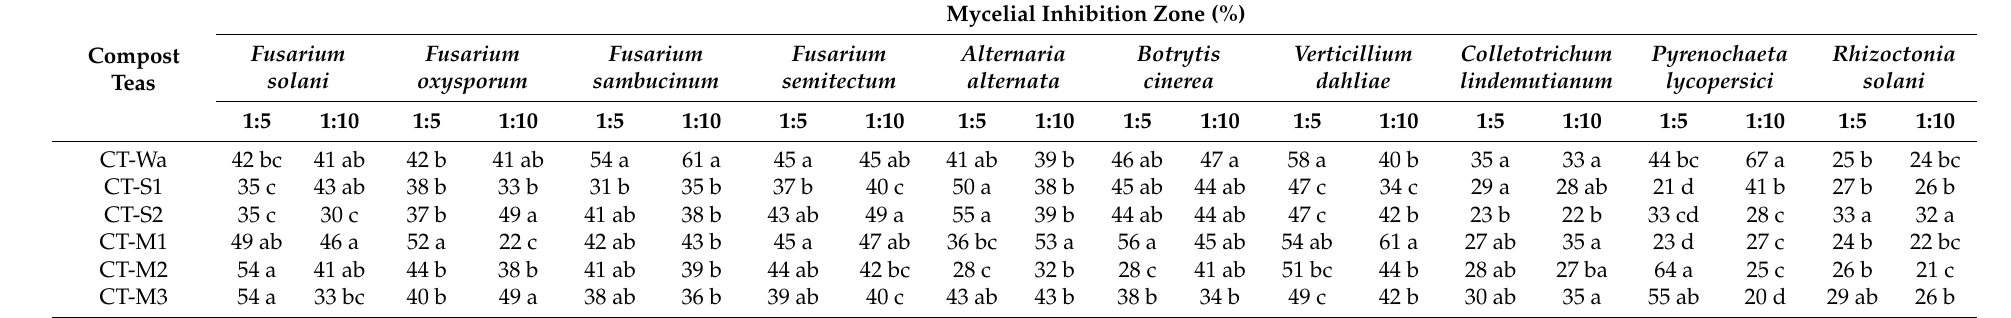
Table 8. In vitro fungal growth inhibition of the final CTs. For each fungus, values followed by different lowercase letters were significantly ( p ≤ 0.05) different.